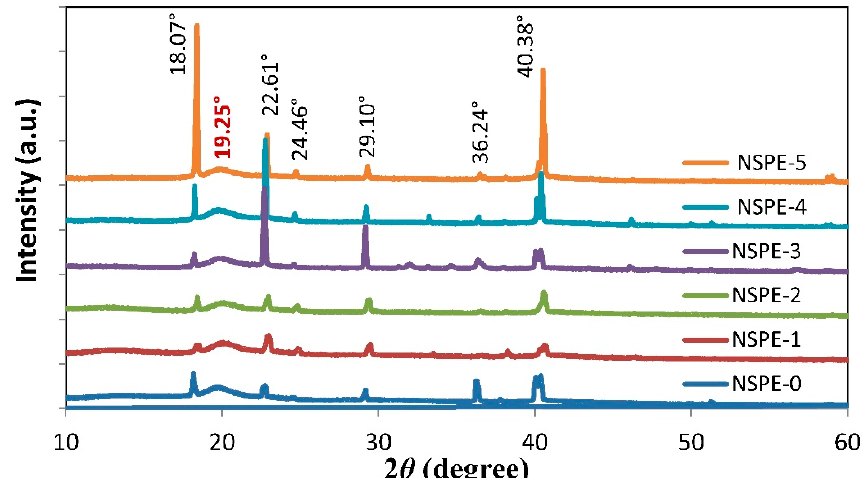
Figure 2. XRD pattern plots for PVA/NH 4 NO 3 /ZnO NSPEs with different ZnO-nanoparticle (NP) contents.